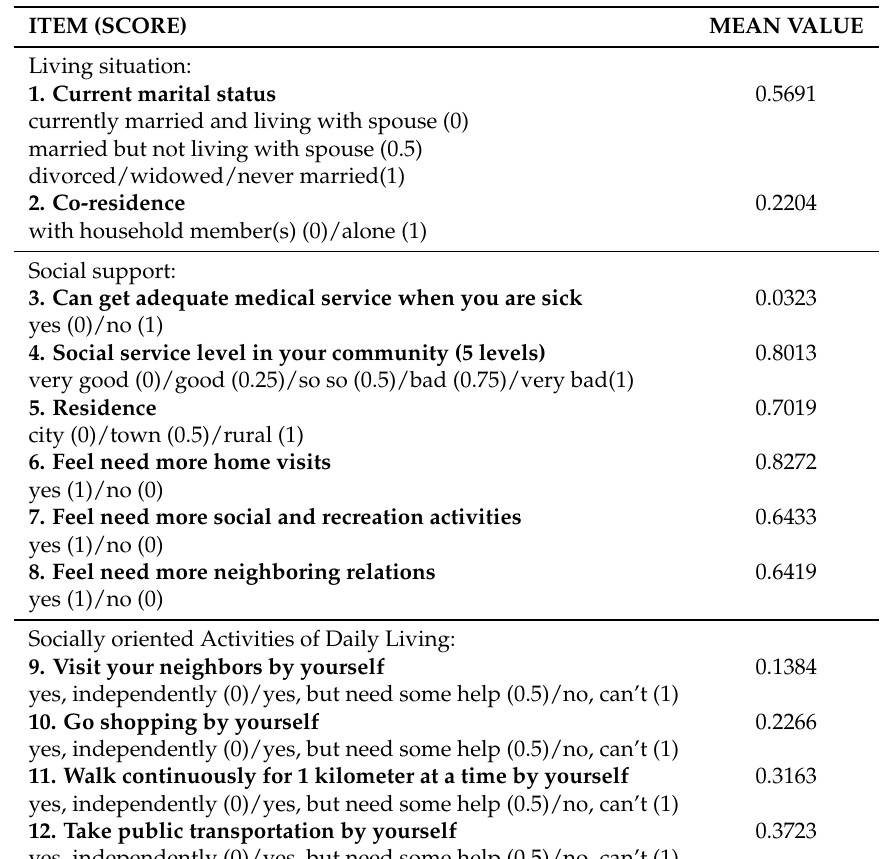
Table 1. Items of the Social